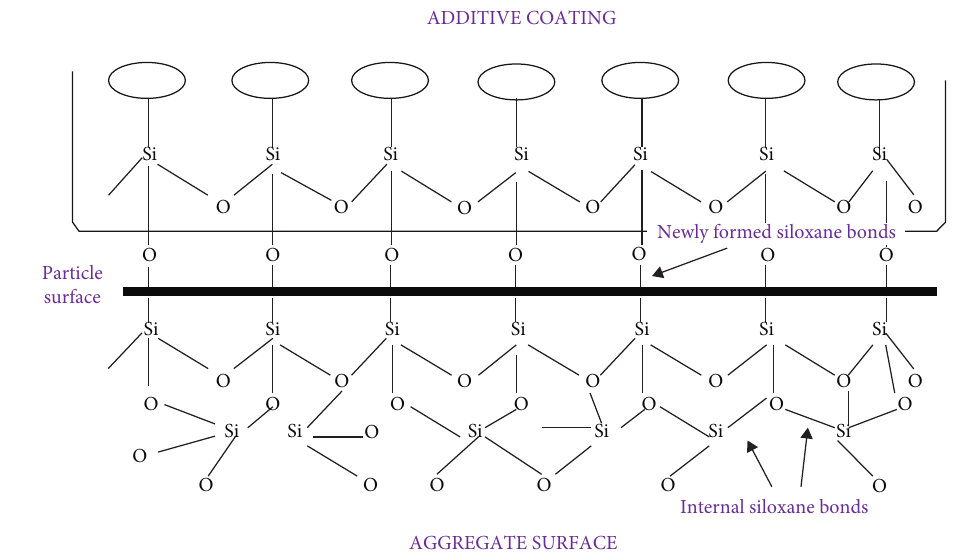
Figure 3: Stabilization mechanism for silicate-containing aggregates with organosilane [30]. Table 2: Main physical properties and water contained in organosilane (from technical